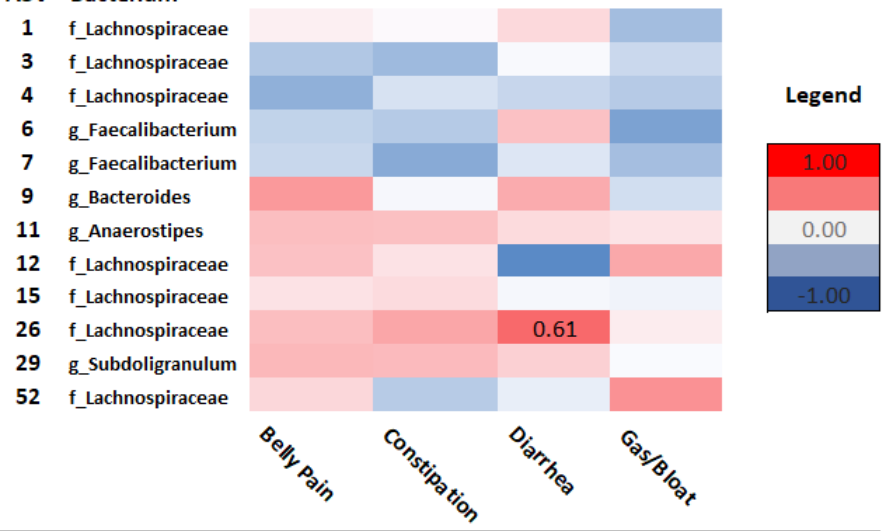
Figure 8. Heatmap of correlations between GI outcomes and ASVs at the order (o), family (f), and genus (g) levels in cancer survivors. Spearman’s rho is presented. (Values for n range from 10–17.)